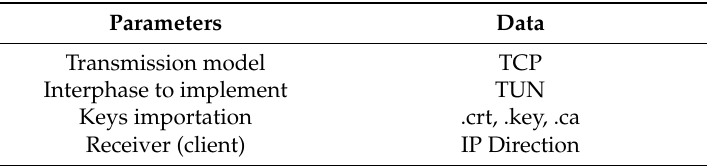
Table 3. Server configuration parameters.